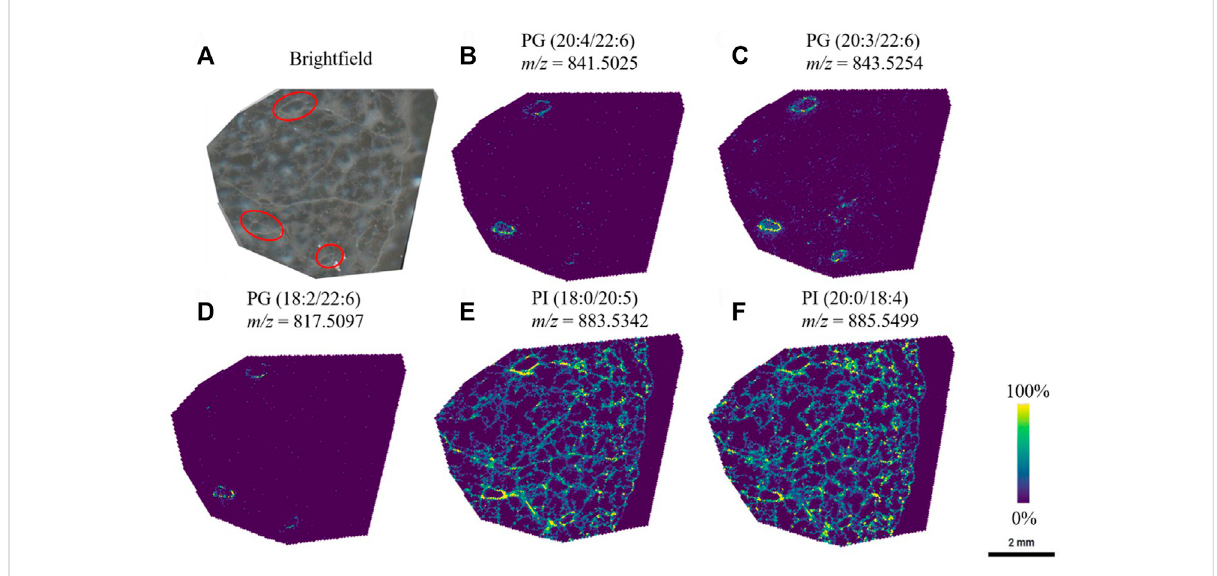
FIGURE 3 PGlipidspecieswereobservedtobelocalizedtoaspeci fi cregion(redcircles)inthelung,whereasotherspecieswerevisualizedthroughoutthe lungtissue. (A) Bright fi eldimageofthelungtissuesection,andthecorrespondingionimagesof (B) PG(20:4/22:6) (C) PG(20:3/22:6) (D) PG(18:2/22: 6) (E) PI(18:0/20:5),and (F) PI(20:0/18:4).Lipidspecieswere fi rstidenti fi edthroughMETASPACEandcon fi rmedbyLC-MS/MS via analysisofthebulk tissue